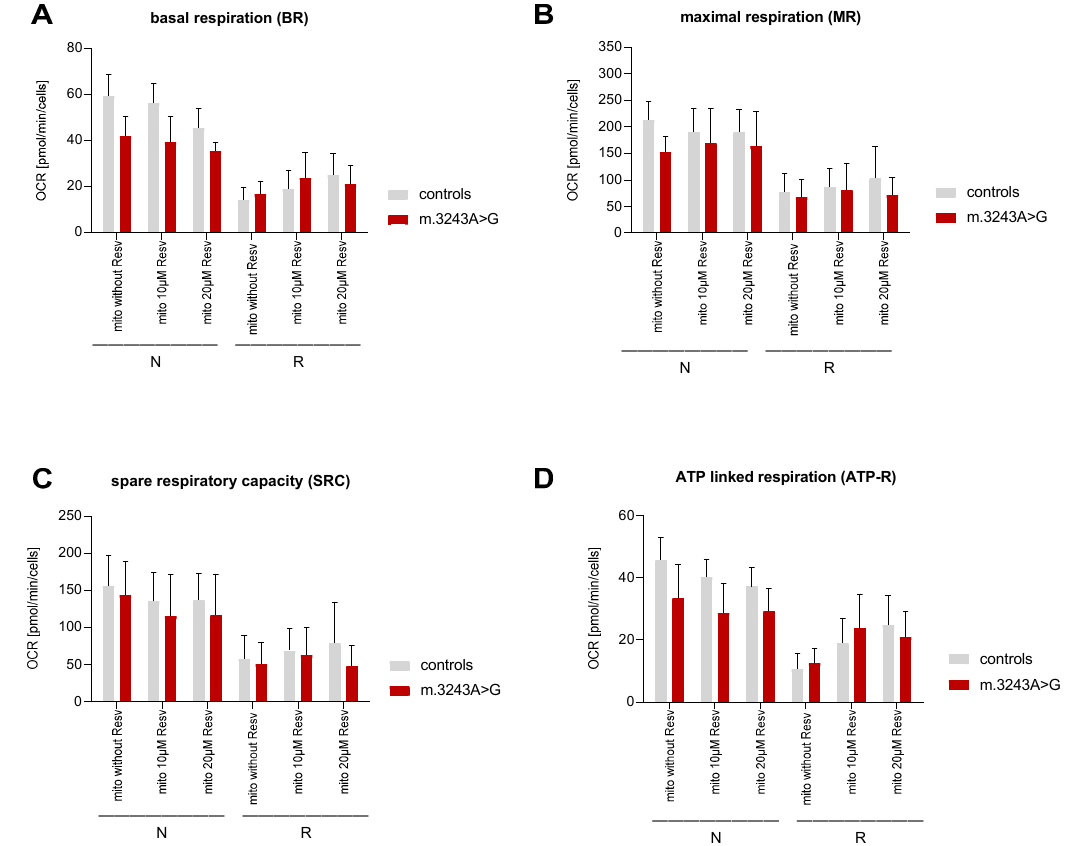
Figure 2. Evaluation of mitochondrial function using a Seahorse XF96 Cell Analyzer in myoblasts from patients (n = 5) and controls (n = 5). The key parameters of mitochondrial function such as basal respiration (BR), ATP production (ATP-R) and spare respiratory capacity (SRC) were analyzed as previously described. ( A ) Basal respiration (BR), ( B ) maximal respiration (MR), ( C ) spare respiratory capacity (SRC) and ( D ) ATP-linked respiration (ATP-R) after 48 h under normal (N) and restricted (R) conditions. The significant differences are shown in Tables 3 and 4, and Table S1.